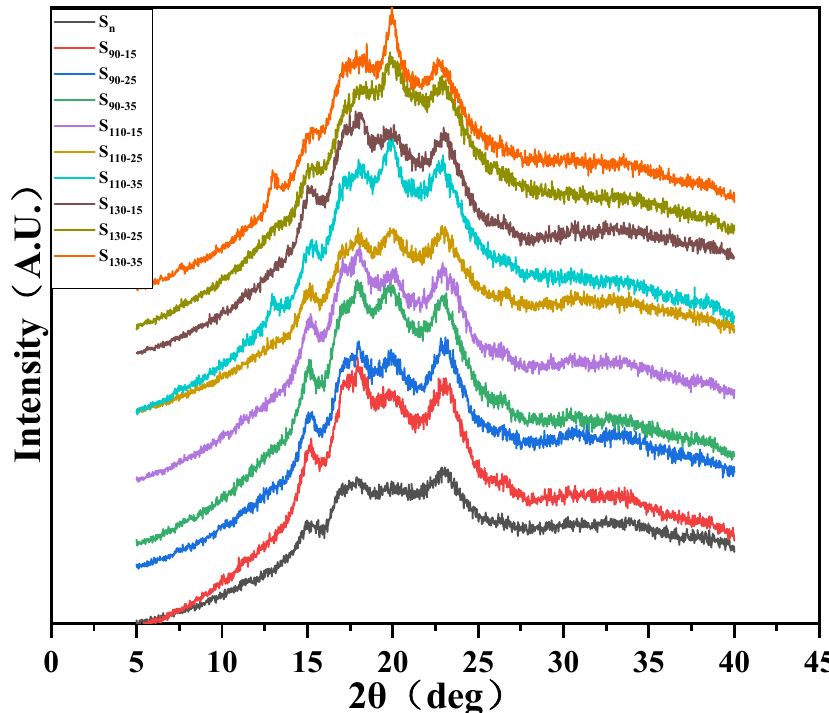
Figure 2. XRD pattern of native and HMT HB flours. S n indicates native HB flour; S 90 − 15 , S 90 − 25 , S 90 − 35 indicate that the heating temperature of HB flour is 90 °C; S 110 − 15 , S 110 − 25 , S 110 − 35 indicate that the heating temperature of HB flour is 110 °C; S 130 − 15 , S 130 − 25 , S 130 − 35 indicate that the heating temperature of HB flour is 130 °C; S 90 − 15 , S 110 − 15 , S 130 − 15 indicate that the moisture content of HB flour is 15%; S 90 − 25 , S 110 − 25 , S 130 − 25 indicate that the moisture content of HB flour is 25%; S 90 − 35 , S 110 − 35 , S 130 − 35 indicate that the moisture content of HB flour is 35%.